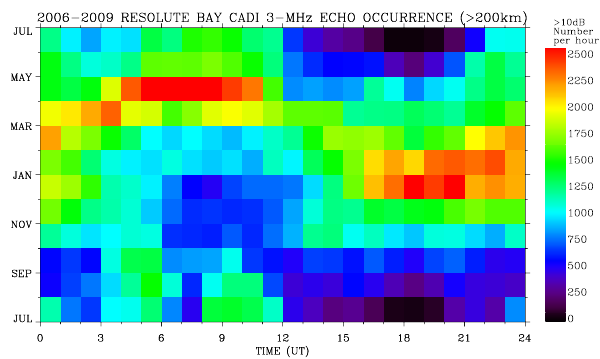
Fig. 10. The 2006–2009 statistics of F-region echoes for CADI in Resolute Bay. Magnetic local midnight and noon at Resolute Bay occur around 07:10 and 19:40UT,